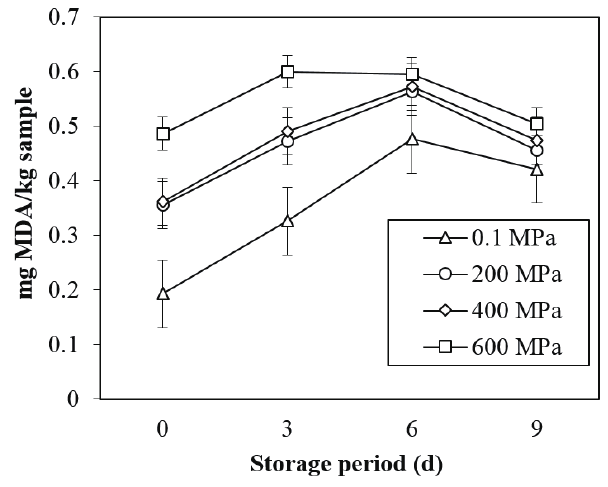
Figure 2. Changes in TBARS values of DFD strip loin subjected with different levels of pressure during refrigerated storage under vacuum. These data are presented as mean±standard deviation. TBARS, 2-thiobarbituric acid reactive substances; DFD, dark-firm-dry; MDA; malondialdehyde.